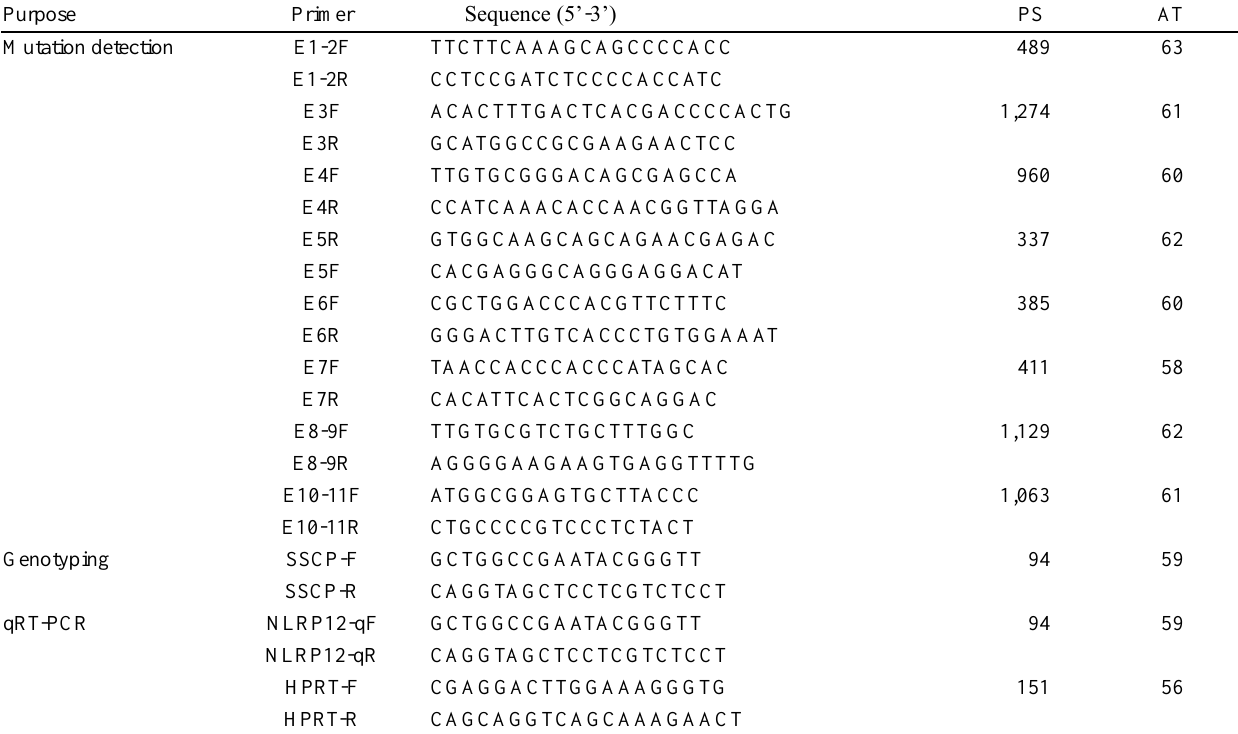
Table 1. Primer pairs used for mutation detection, genotyping, and qRT-PCR analyses of NLRP12 gene Purpose Primer Sequence (5’-3’) AT Mutation